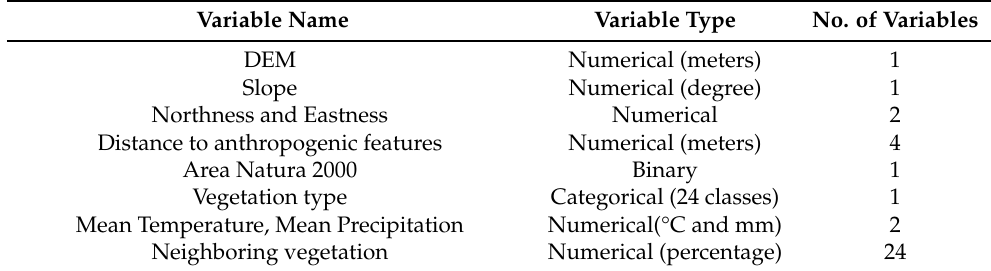
Table 1. Input data of the machine learning model.